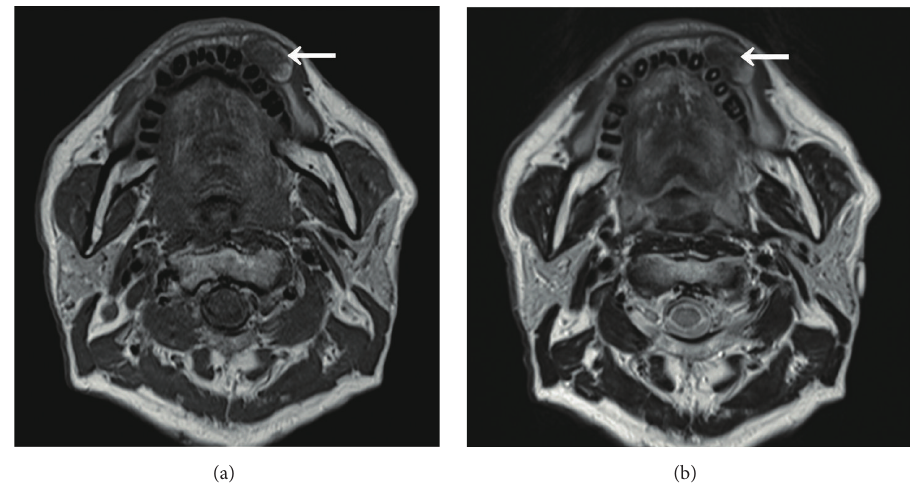
Figure 2: MRI findings of the lesion. MRI showed a well-defined mass that exhibited low signal intensity on both (a) T 1 - and (b) T 2 -weighted images.